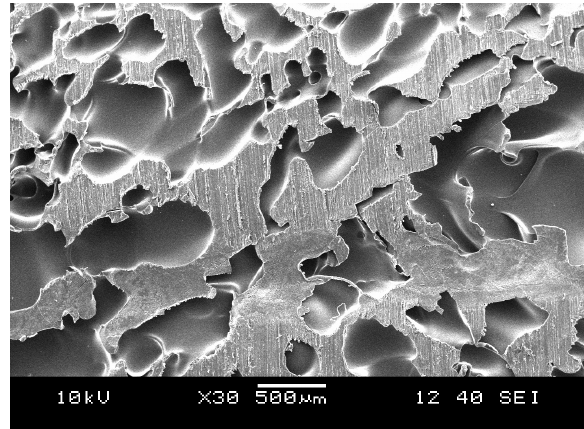
Figure 5. Gas bubbles on and near the steel-polymer interface and adhesive failure of the PMMA (SEM image of the PMMA